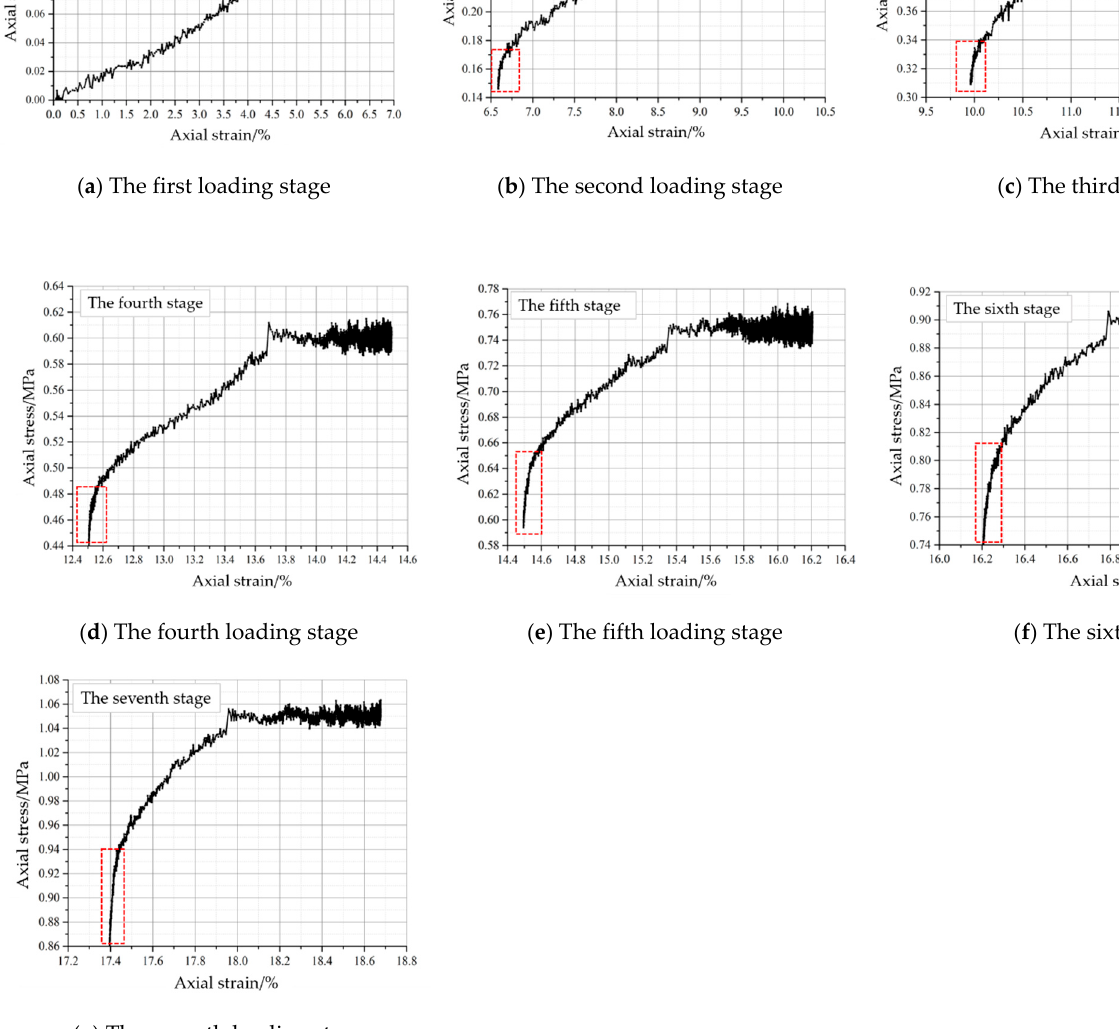
Figure 10. The periodic stress-strain curves of sample S-1 at each loading stage.